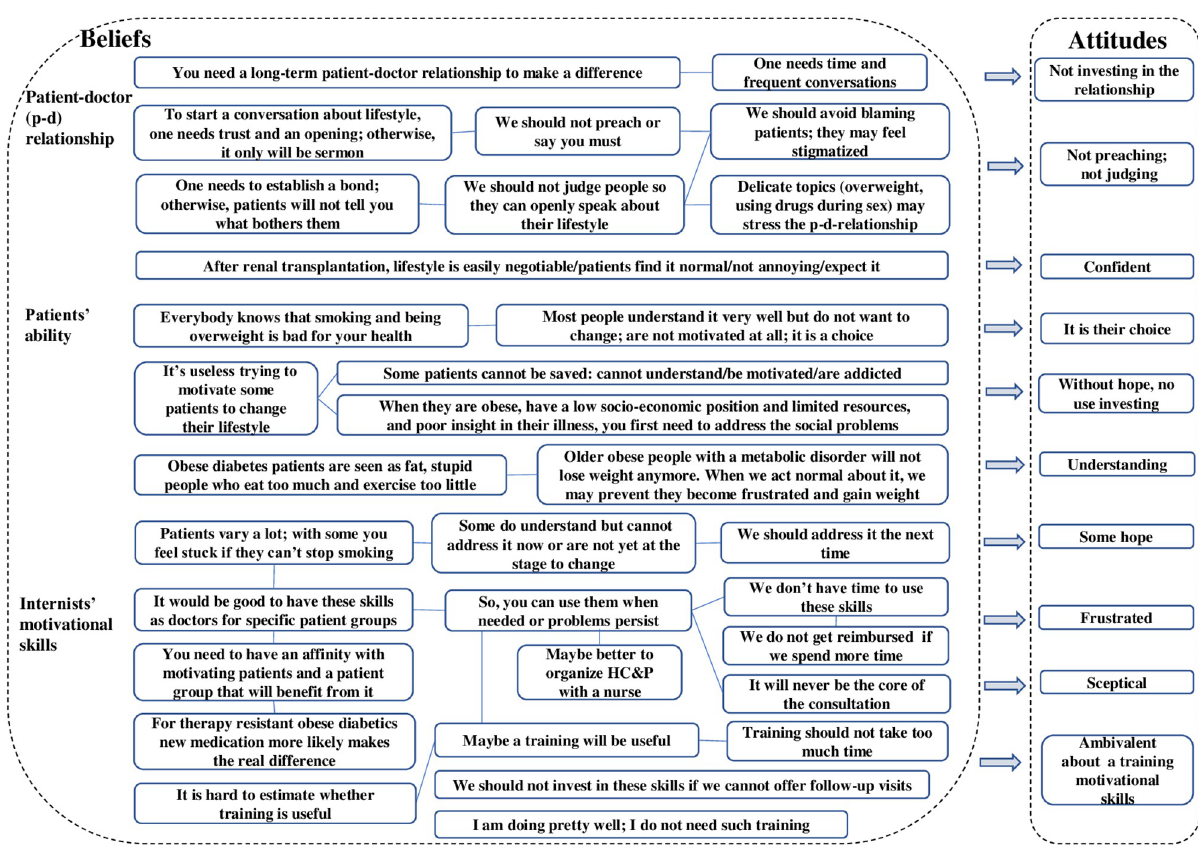
Fig 4. Schematical overview of beliefs and attitudes about the patient-doctor relationship, the patients’ ability, and the internists’ motivational skills.